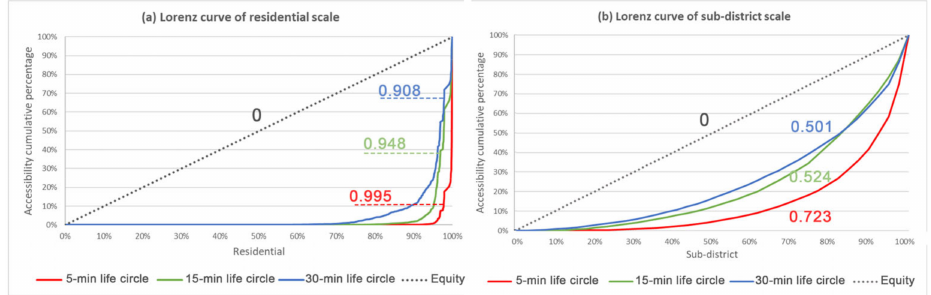
Figure 6. Gini coefficient and Lorenz curve under different scales. ( a ) Residential scale. ( b ) Sub- district scale.